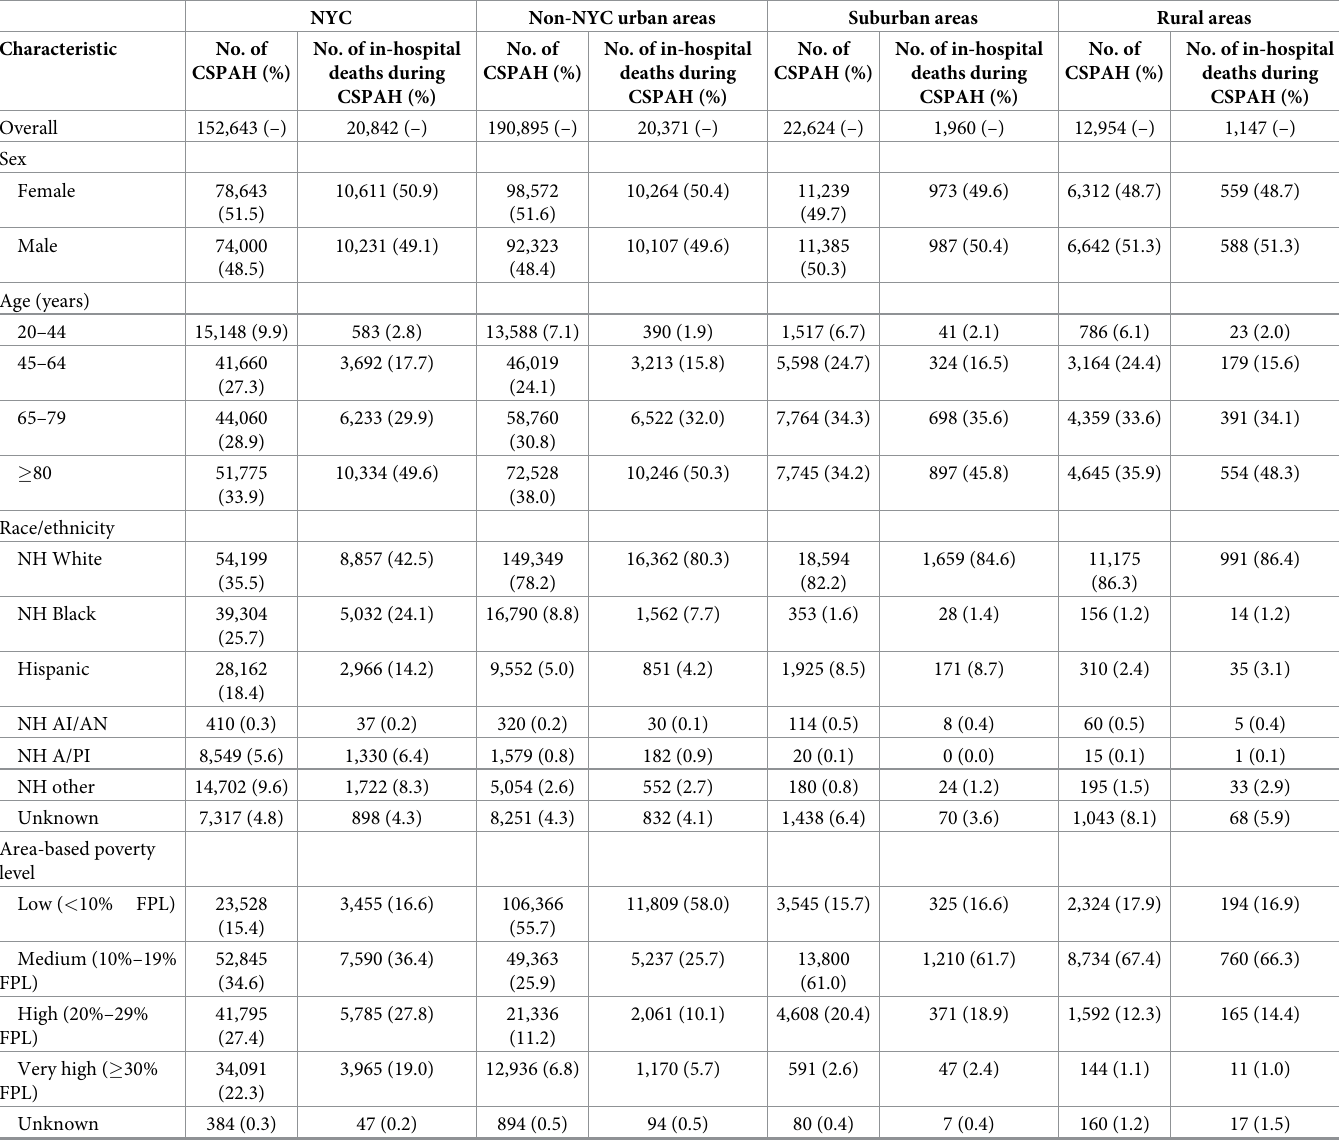
Table 1. Characteristics of community-setting pneumonia-associated hospitalizations and associated in-hospital deaths in New York City, non-New York City urban areas, suburban areas, and rural areas—New York State, 2010–2014 a . NYC Non-NYC urban